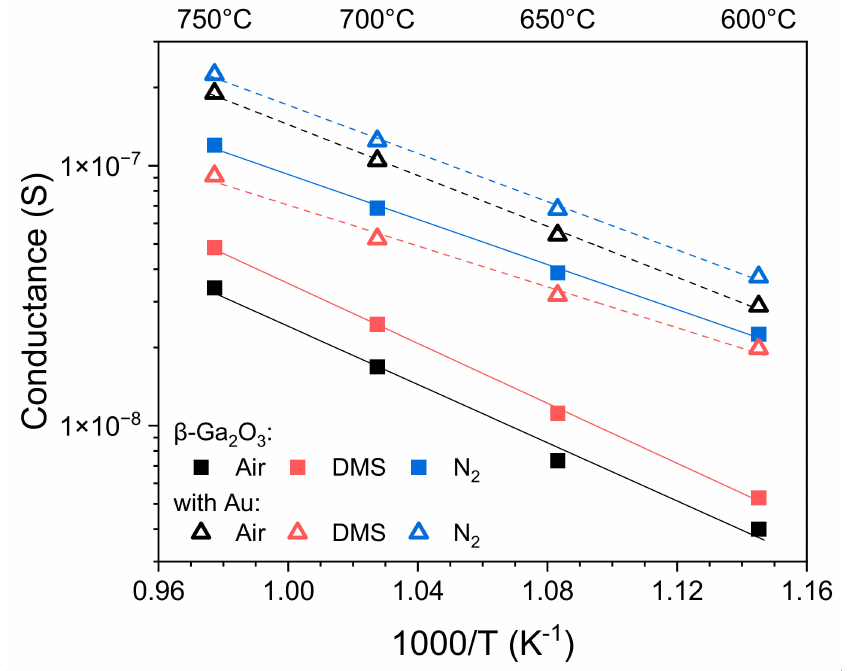
Figure 12. Conductance of β -Ga 2 O 3 epitaxial layer, before and after its modification with Au nanoparticles, in the atmosphere of air, nitrogen, and air containing 16 ppm of dimethyl